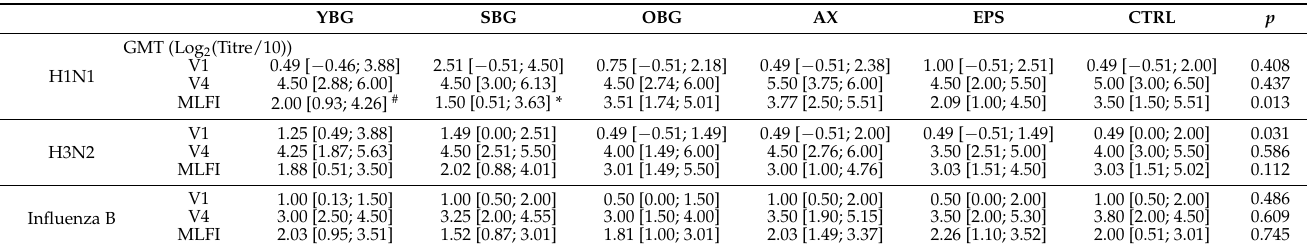
Table 4. Micro-neutralization titres at baseline (V1) and three weeks after vaccination (V4) in the different NPS interven- tion groups. YBG SBG OBG AX EPS CTRL p